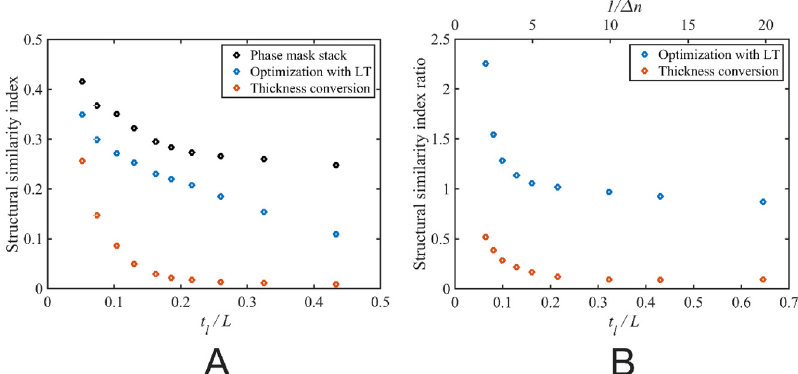
Figure 4: (A) Averaged structural similarity index of output fields LP 02 and LP 21 vs t l / L (thickness variation/layer separation). (B) Averaged structural similarity index of output fi elds LP 02 and LP 21 divided by the average structural similarity index of corresponding discretized phase mask stack vs t l / L and equivalently 1 / Δ n for this scenario. See Section 1 and 2 of the Supplementary Material for more